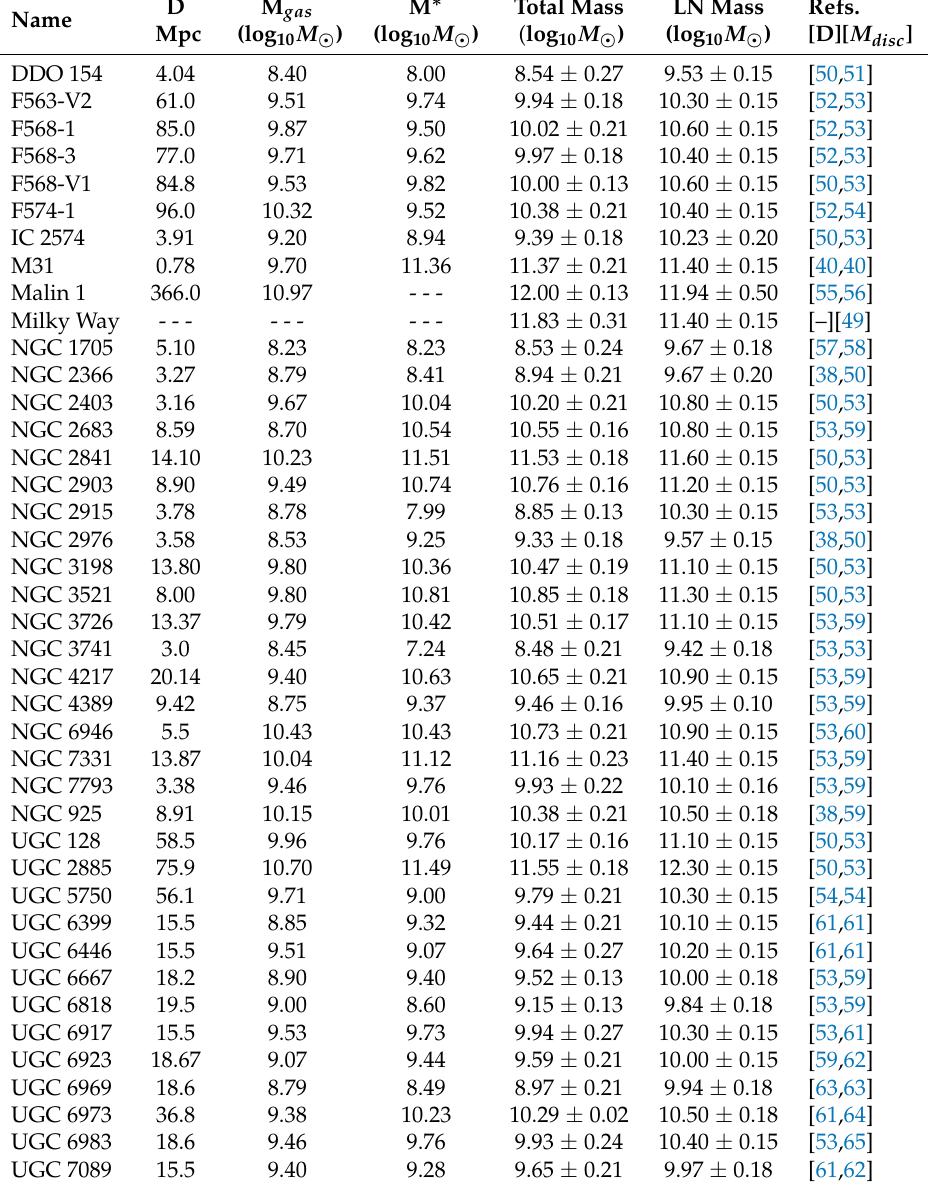
Table 1. Observational masses and computed lognormal masses for 41 disc